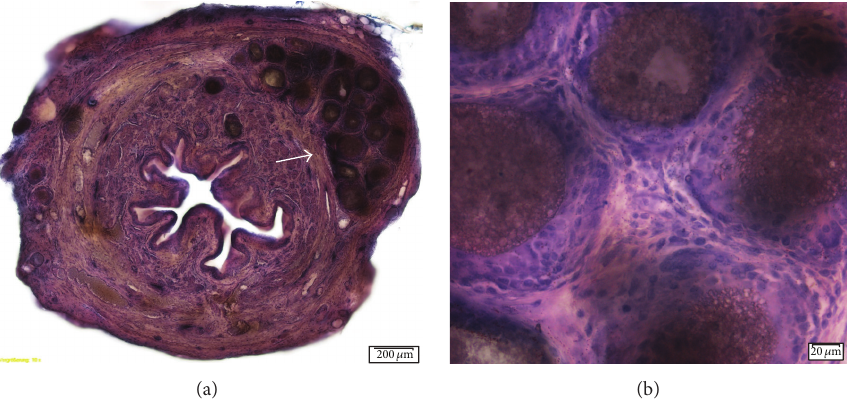
Figure 4: (a) Cross-sections of urethra 5 months after injection of Coaptite (10x magnification). Arrow pointing to particle mass. (b) Image showing particles surrounded by fibroblasts and giant cells. Relatively uniform size of the injected